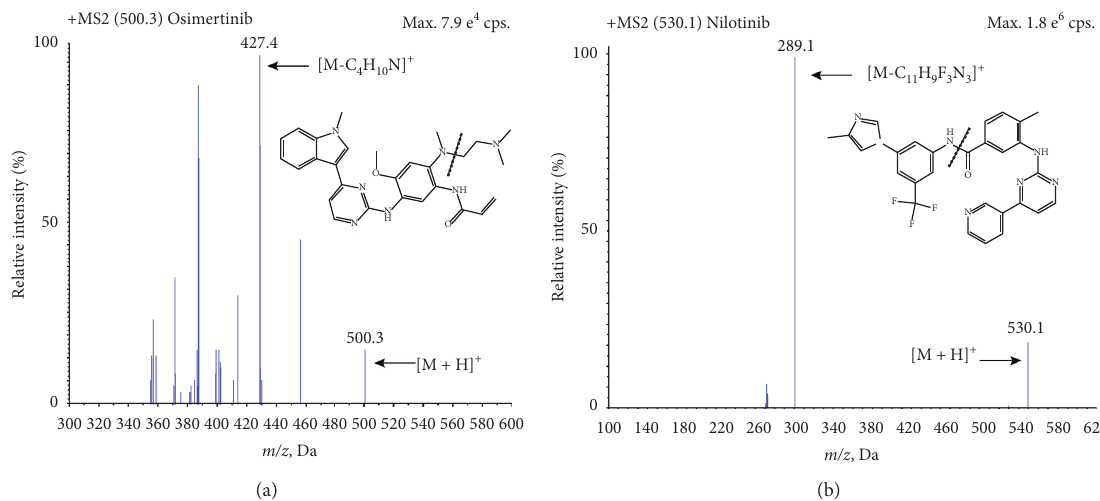
Figure 2: Product ion mass spectra of osimertinib (a) and nilotinib (b) in positive mode and their proposed fragmentation